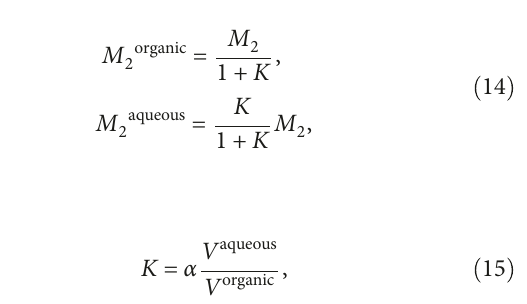
= 9 25 mol, T = 80 ° C, 2